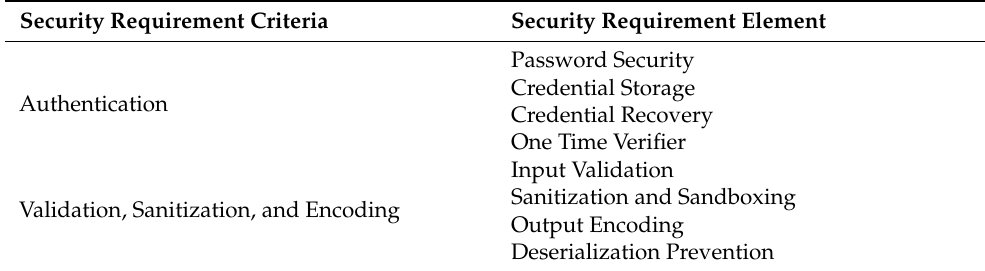
Table 2. Exemplary assurance elements (security requirement elements).